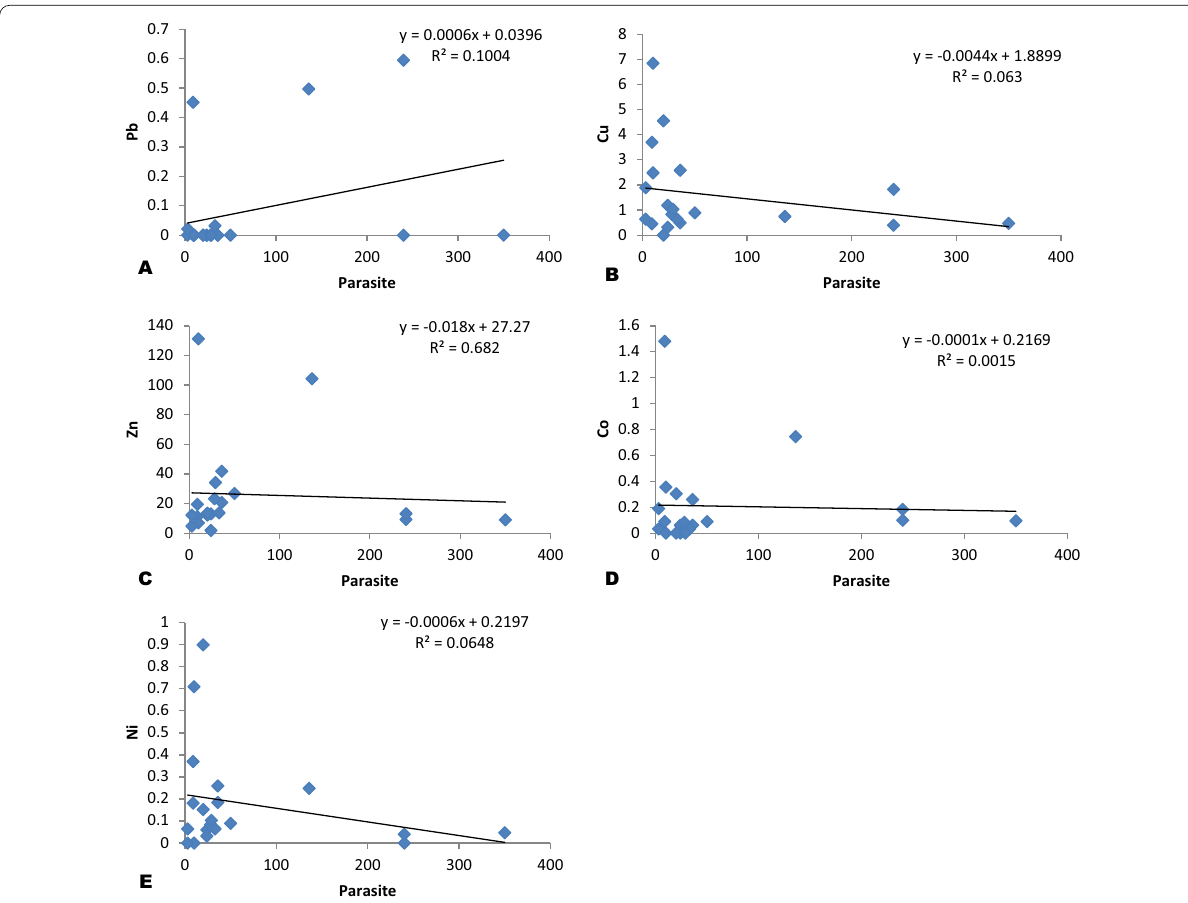
Regression analysis of lead, =